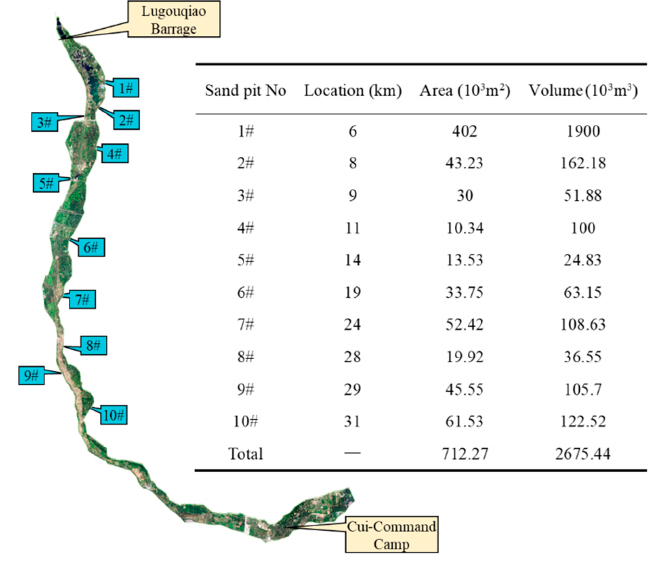
Figure 4. Information of large potholes in southern plain reach.